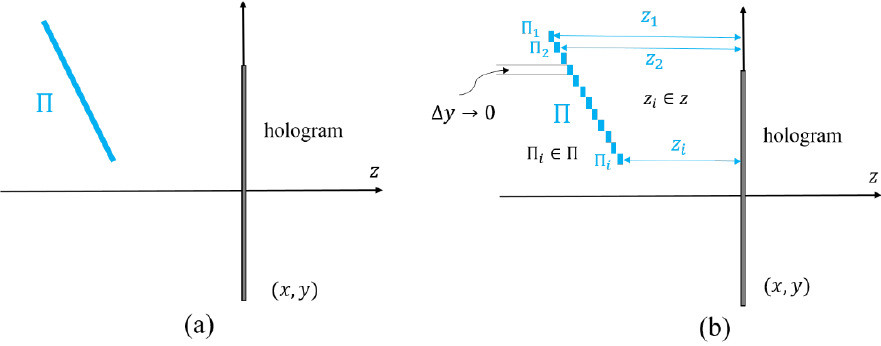
Figure A1. ( a ) Tilted triangle Π in the global coordinate system, ( b ) discrete version of Π Appendix C. Derivation of the Analytical Spectrum Expression of Tilted Triangle on the Hologram